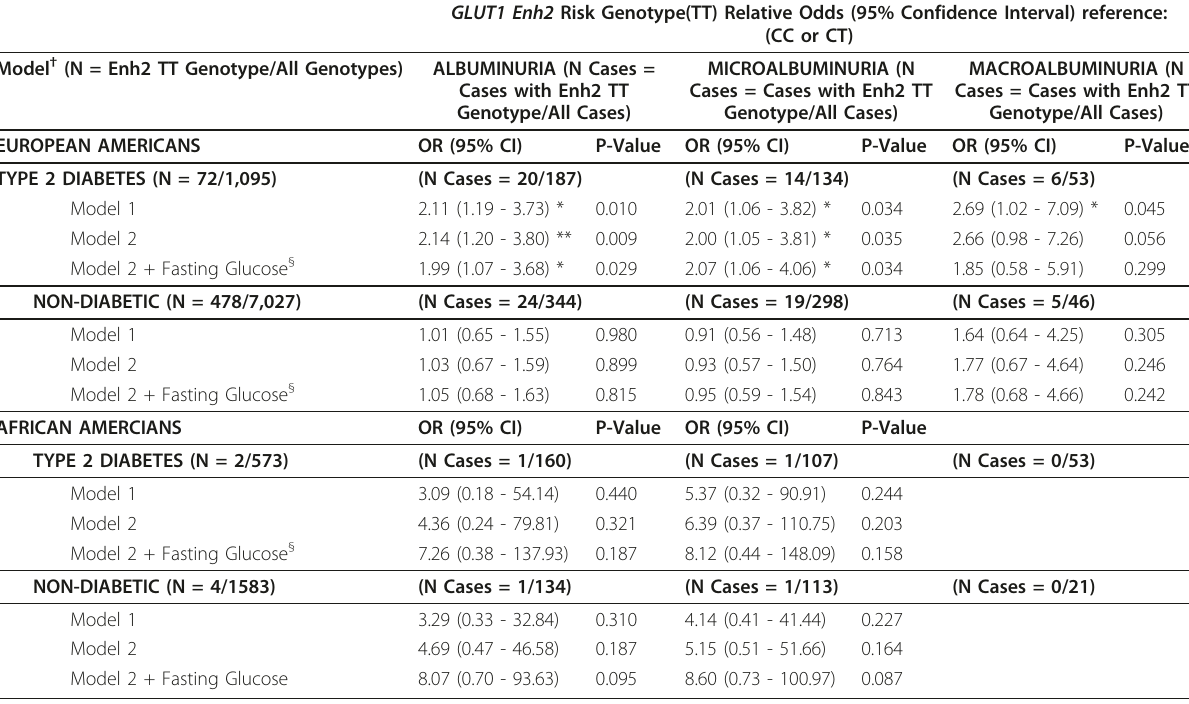
Table 4 Adjusted relative odds of albuminuria, microalbuminuria, and macroalbuminuria for Enh 2 in all genotyped European Americans and African Americans, by type 2 diabetes status GLUT1 Enh2 Risk Genotype(TT) Relative Odds (95% Confidence Interval) reference: (CC or CT) Model † (N = Enh2 TT Genotype/All